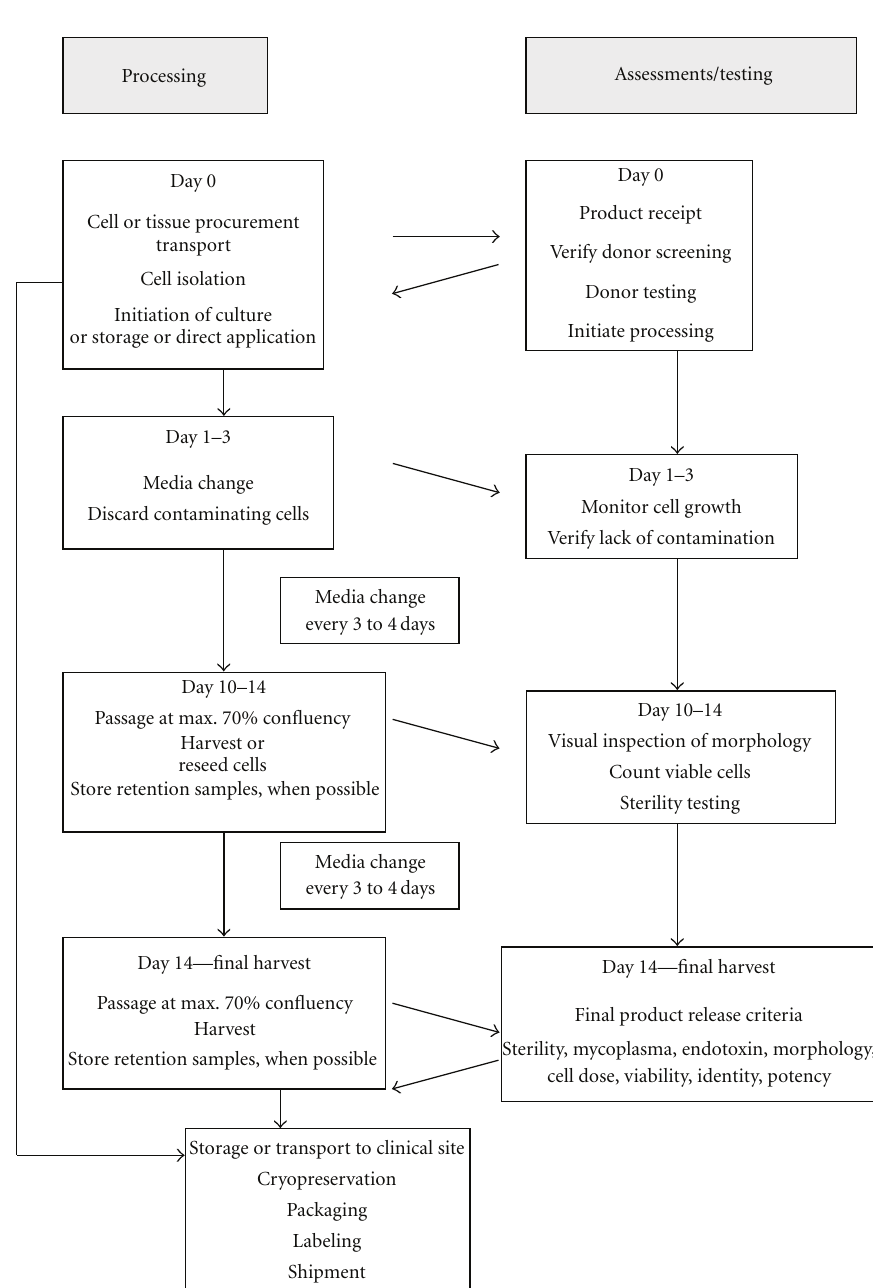
Figure 1: Flow chart illustrating essential processing and testing steps during MSC manufacture. This scheme summarisesa GMP-compliant manufacturing process of MSC expansion separated into processing and related testing activities. On day zero the tissue is harvested and transported to the processing lab. Here donor eligibility criteria are checked again and donor testing/reception control initiated (viral, bacterial, blood group, condition, weight, if applicable cell counting, etc.). Verified reception control is a prerequisite for starting processing in the GMP facility. Here cell isolation is performed and expansion cultures initiated or the product is directly applied to the patient. Predefined in-process controls shall be taken at any critical processing step to verify cellular qualities and sterility. If expansion is initiated, normal protocols include a medium exchange step concomitantly depleting contaminating cells. Cell growth can be monitored visually as well as potential contamination. Passaging of the cells can be performed within the next 14 days involving controls for morphology, viability, and sterility. Assuming day 14 for the day of harvest and product release, cells have to be specified against predefined final product release criteria. The product can then be cryopreserved allowing for additional potency assays or directly transported to the recipient. Packaging, labeling, and shipment conditions again have to follow GMP